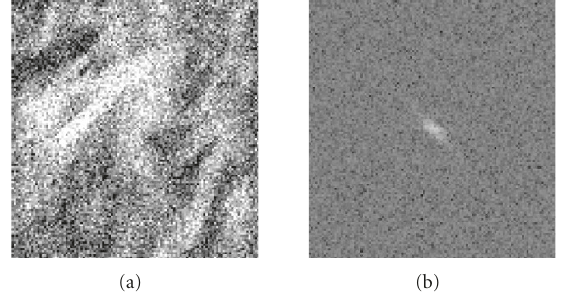
Figure 5: (a) The image (256 × 256) of Barbara which is degraded by motion blur with parameters L = 30 pixels, φ = 45 ◦ and Gaussian additive noise with zero mean and variance = 0 . 04 (SNR = 30dB). (b) its Fourier spectrum.